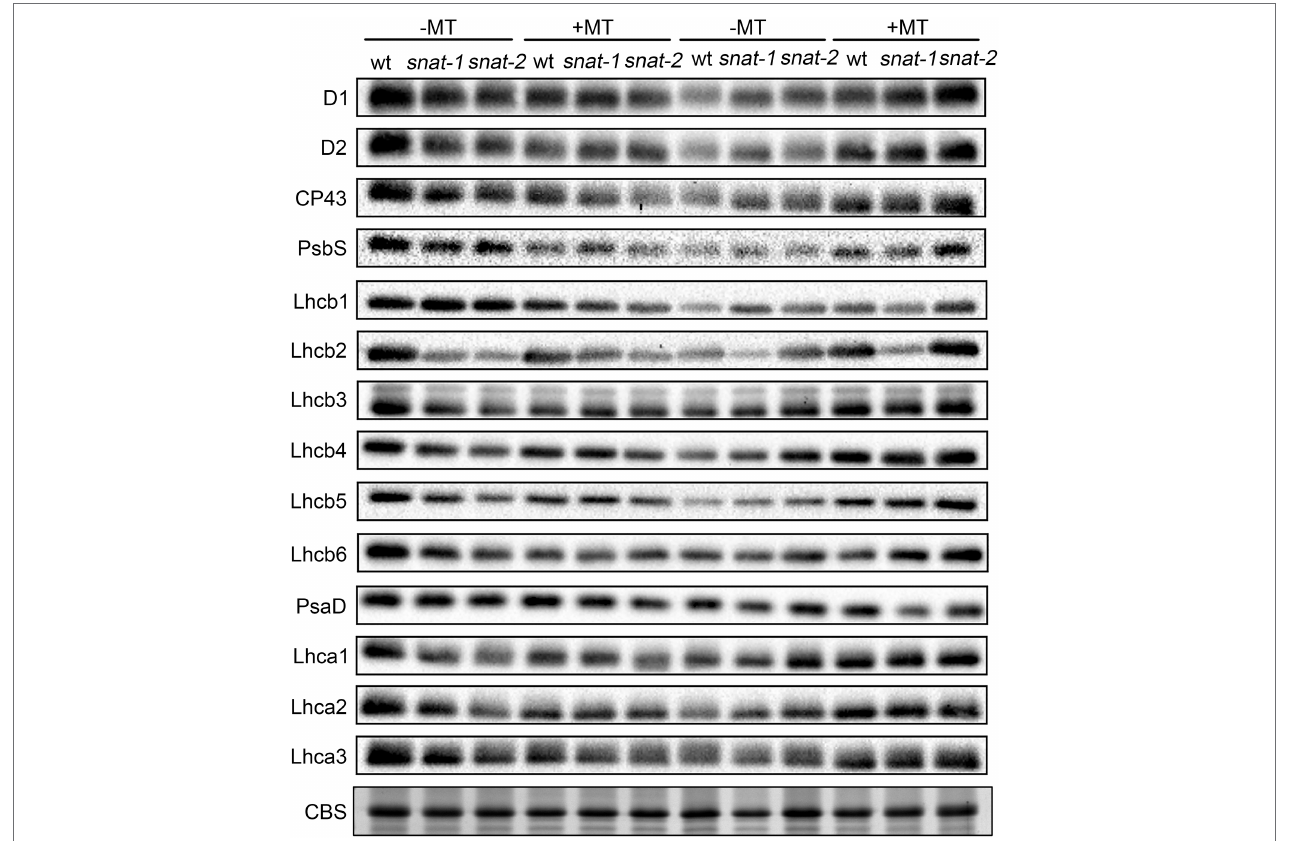
FIGURE 8 | Effects of exogenous melatonin on thylakoid membrane proteins. Immunoblotting was performed with antibodies against D1, D2, CP43, PsbS, Lhcb1, Lhcb2, Lhcb3, Lhcb4, Lhcb5, Lhcb6, PsaD, Lhca1, Lhca2 and Lhca3. SDS-PAGE of thylakoid proteins stained with coomassie brilliant blue (CBS) worked as loading